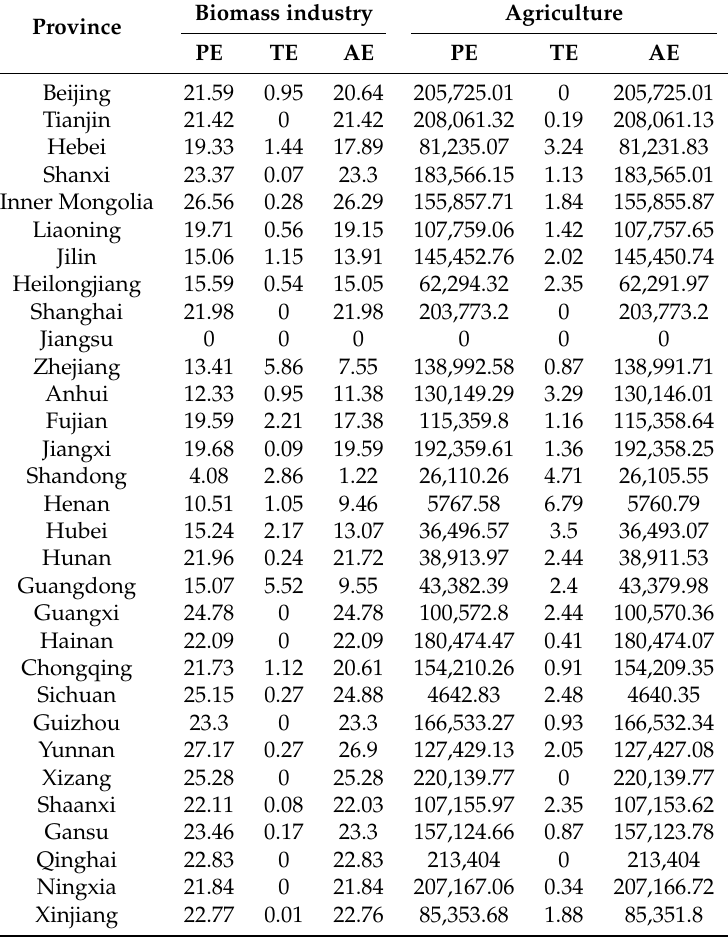
Table 6. Inefficiency decomposition for the biomass industry and agriculture in China (million RMB). Biomass Province